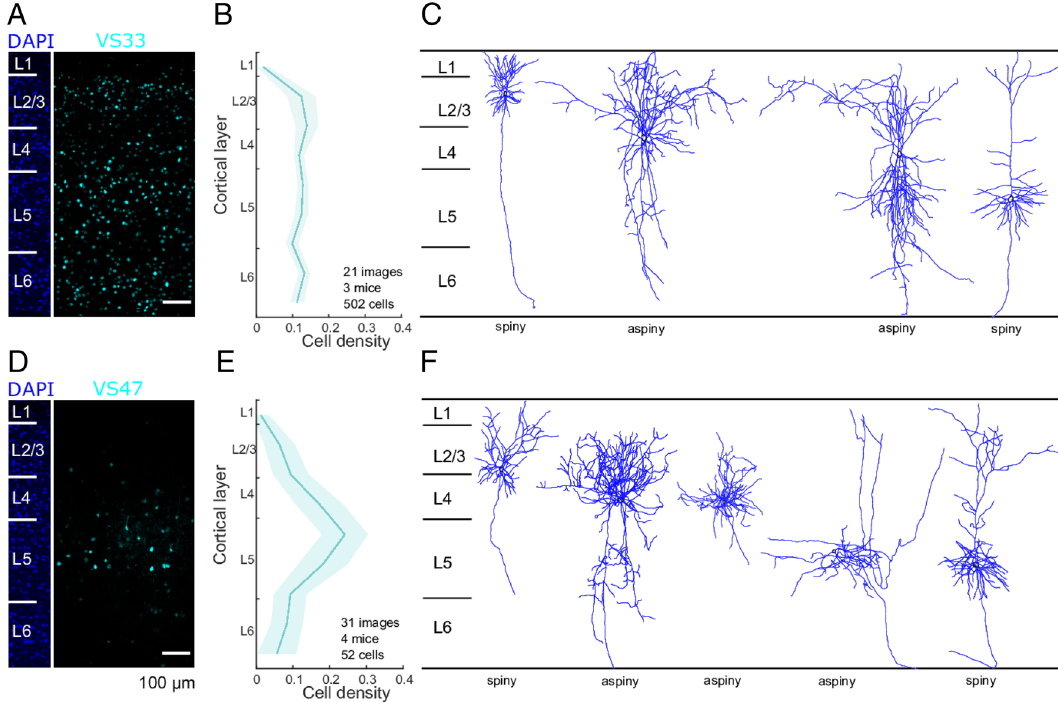
Figure 5. Cortical layer distribution and neuronal morphology of validation sequences VS33 and VS47 in coronal sections of the auditory cortex. ( A , D ) Example fluorescence microscopy image of a cortical slice depicting mTFP expression driven by VS33 ( A ) or VS47 ( D ). Six neocortical layers indicated on DAPI image. ( B , E ) Distribution of mTFP-expressing cells across cortical layers (mean across images ± SD) for VS33 ( B )